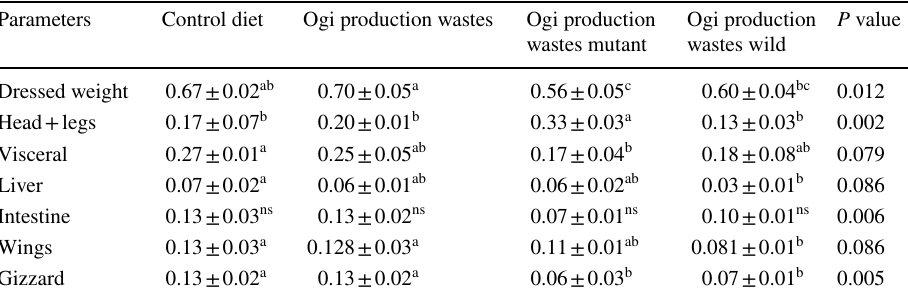
Values are mean ± standard deviation, mean with different superscripts within the same row are signifi- cantly ( P < 0.05) different